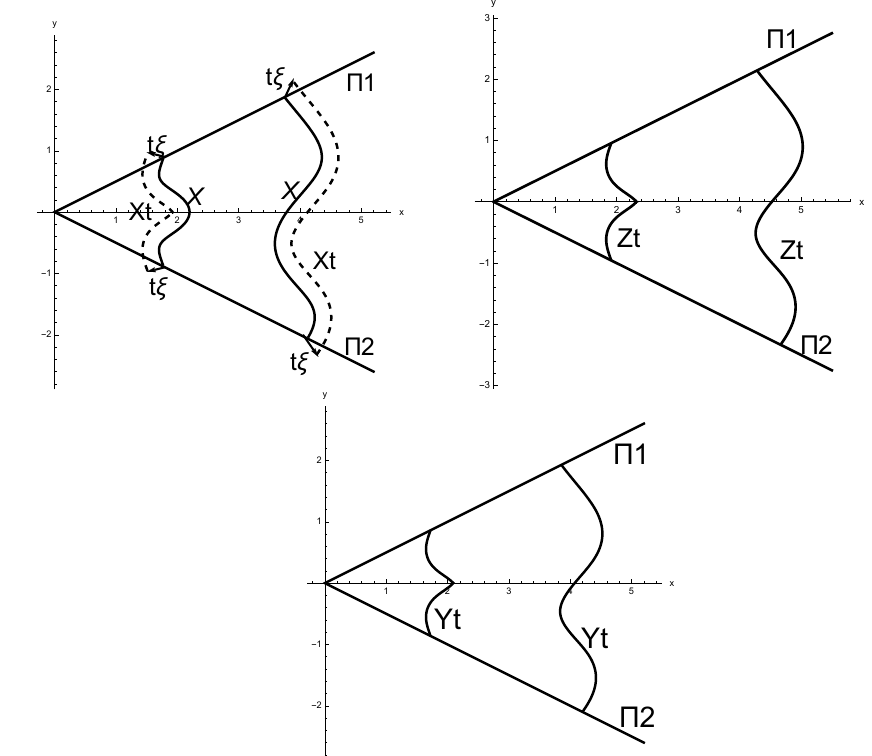
Figure 6. Construction of volume-preserving variation Y t using anisotropic parallel surfaces X t of X . Upper left: A capillary surface X and its anisotropic parallel surface X t . Upper right: A parallel translation Z t of X t that satisfies the boundary condition. Bottom: A homothety Y t of Z t that satisfies the volume